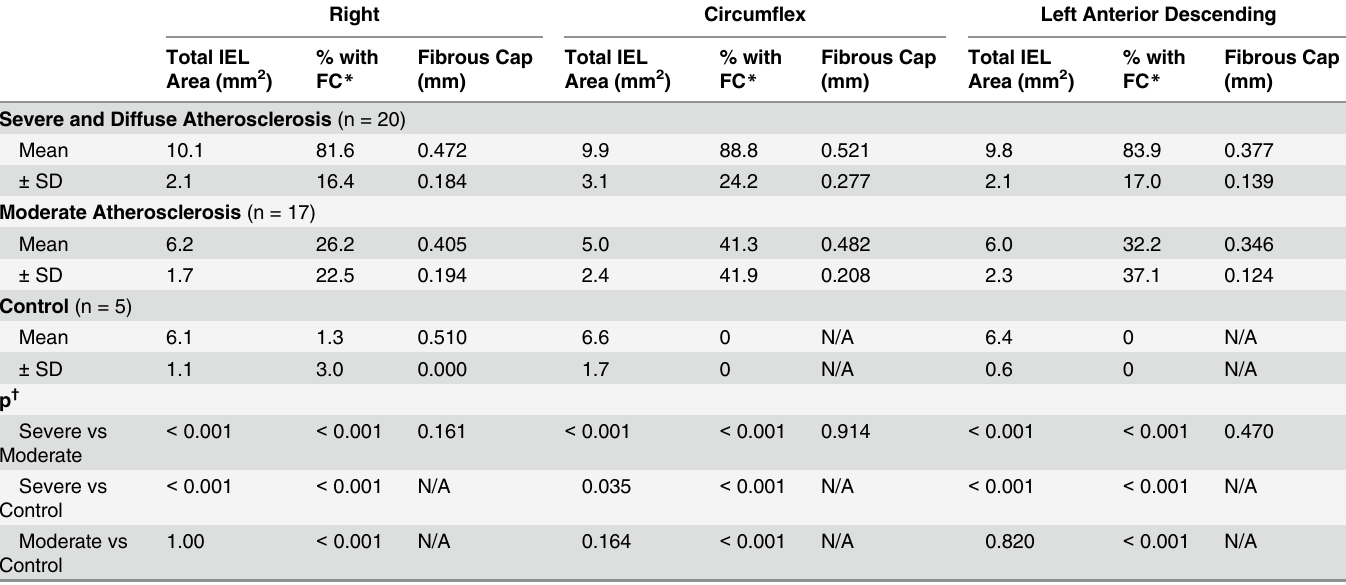
Table 2. Mean Coronary Artery Total IEL Area (mm 2 ), Percent of Coronary Artery Cross Sections Containing Fibrous Caps (FC), and Fibrous Cap Thickness (mm) in All 3 Coronary Arteries.